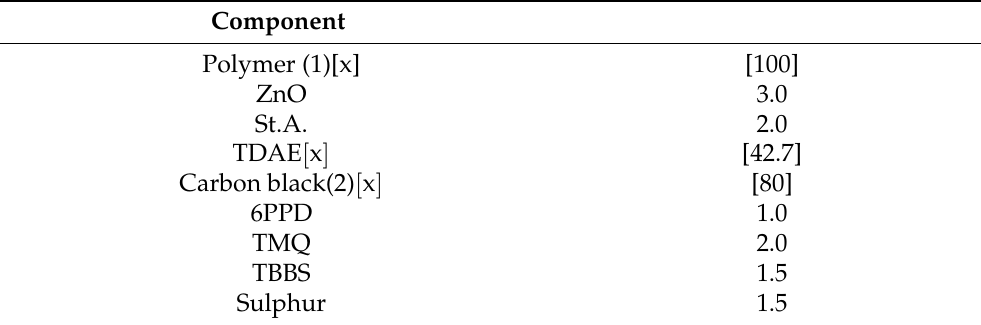
Table A1. Re-vulcanization formulation for a de-vulcanized carbon black based tire tread, values in parts per hundred rubber